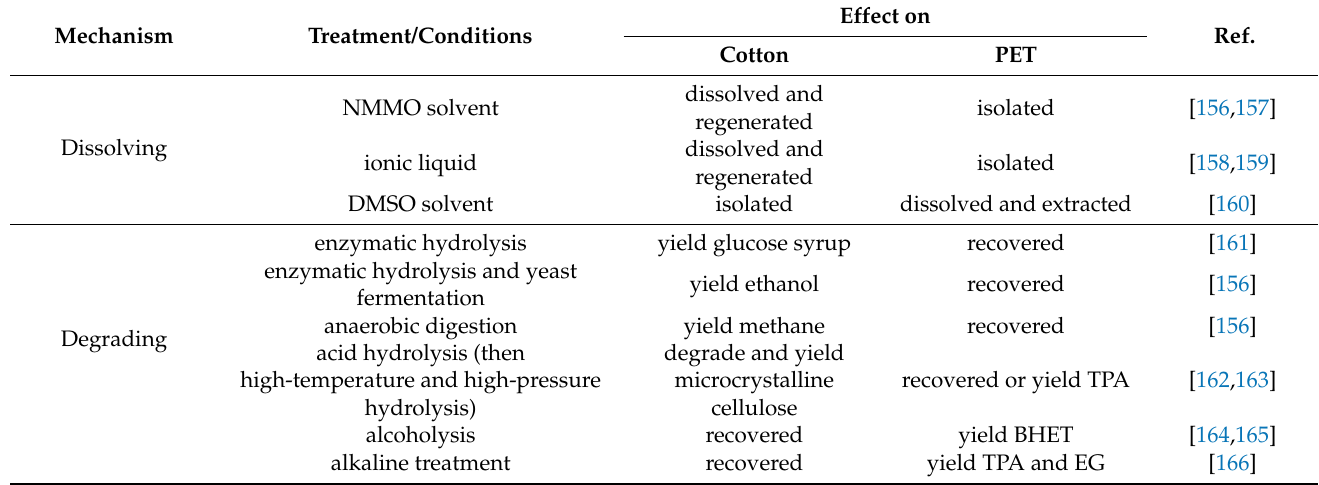
Table 5. Different separation and recycling approaches for polyester/cotton